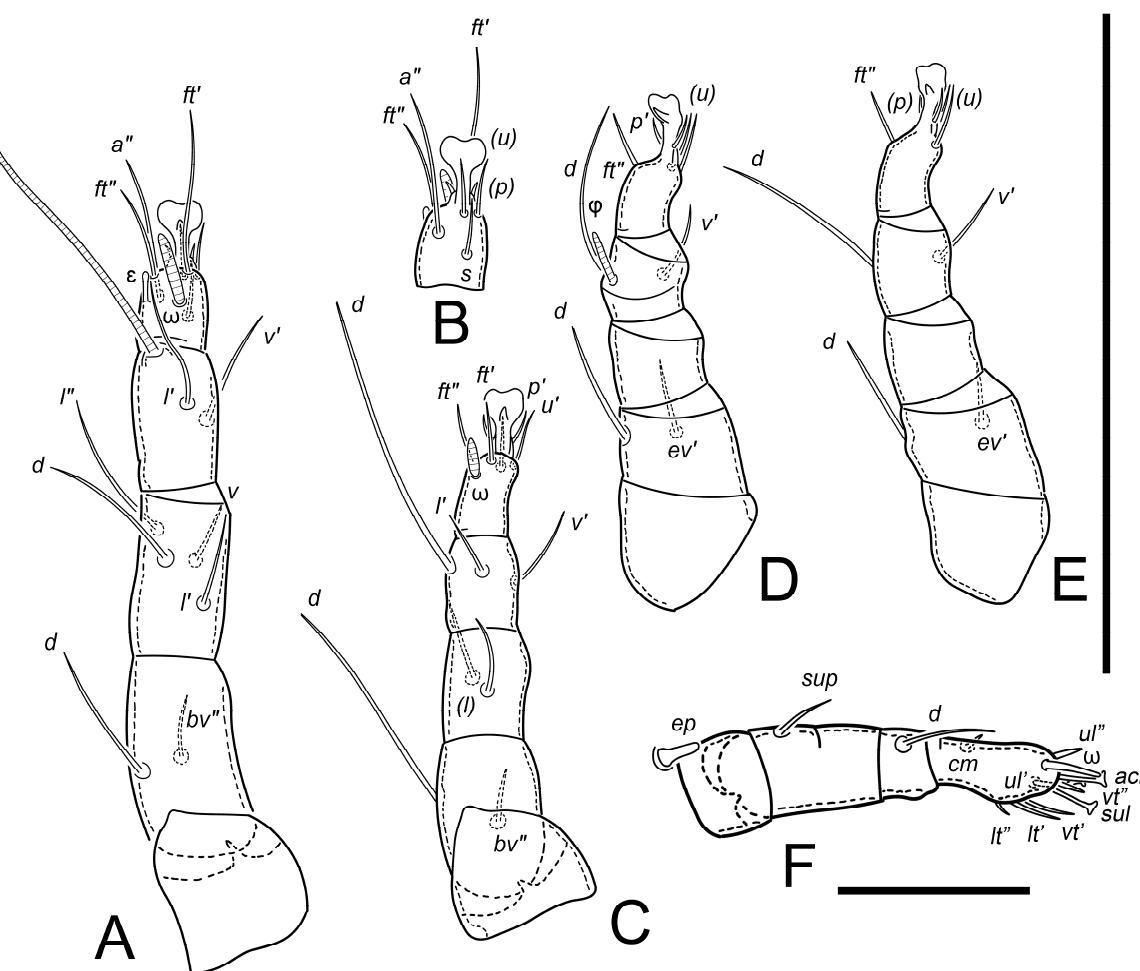
Figure 12. Paralycus daeira sp. n., tritonymph: ( A )—leg I, left, dorsal view; ( B )—tarsus I, left, ventral view; ( C )—leg II, left, dorsal view; ( D )—leg III, right, paraxial view; ( E )—leg IV, right, paraxial view; ( F )—palp, left, dorsal view. Scale bar 50 µm ( A – E ), 10 µm ( F ). Type material. The holotype (female) and paratypes (1 larva, 1 protonymph, 2